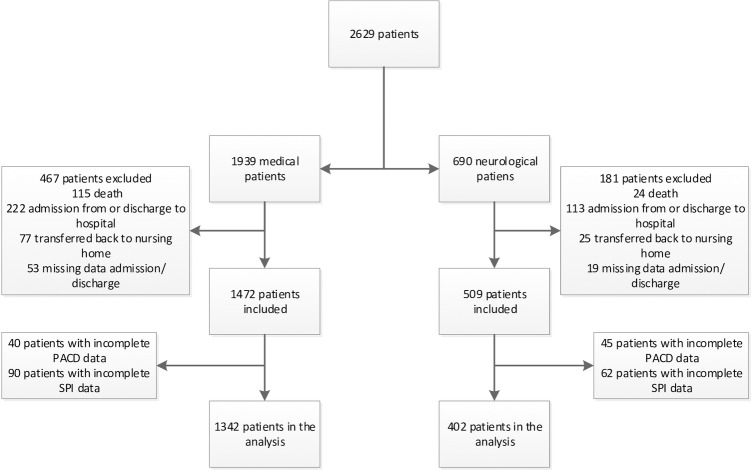
Flow-Chart recruiting process.There were 1342 medical and 402 neurological patients included in the analysis from a possible 2629 patients. Abbreviations: PACD: post-acute care discharge score; SPI: self-care index.